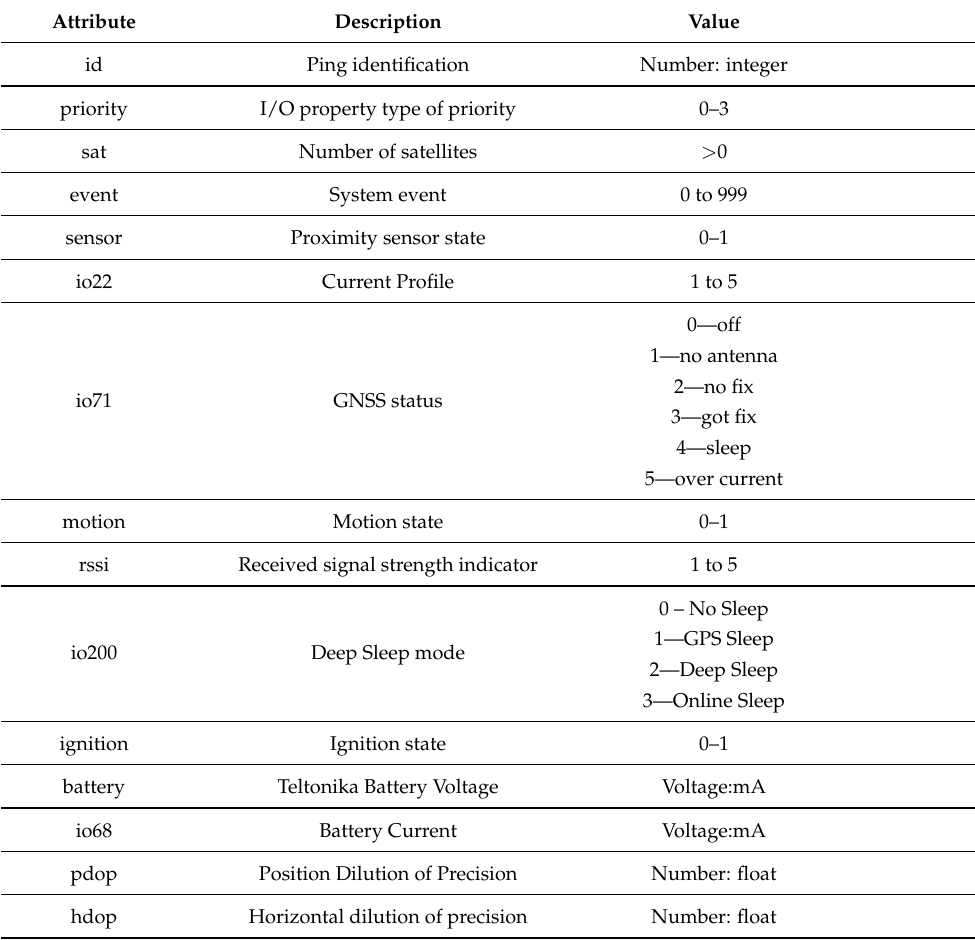
Table A1. Data structure, from the combination of Traccar Server and Teltonika device